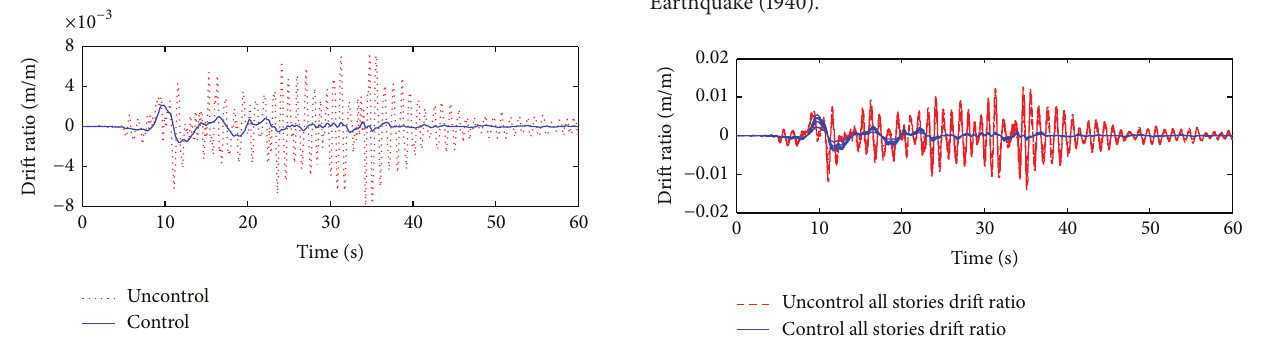
Figure 11: Time history graphs of drift ratio of fifth floor for uncontrolled and synchronized control coupled with 𝐻 2 / LQG algorithm in Bam Earthquake.